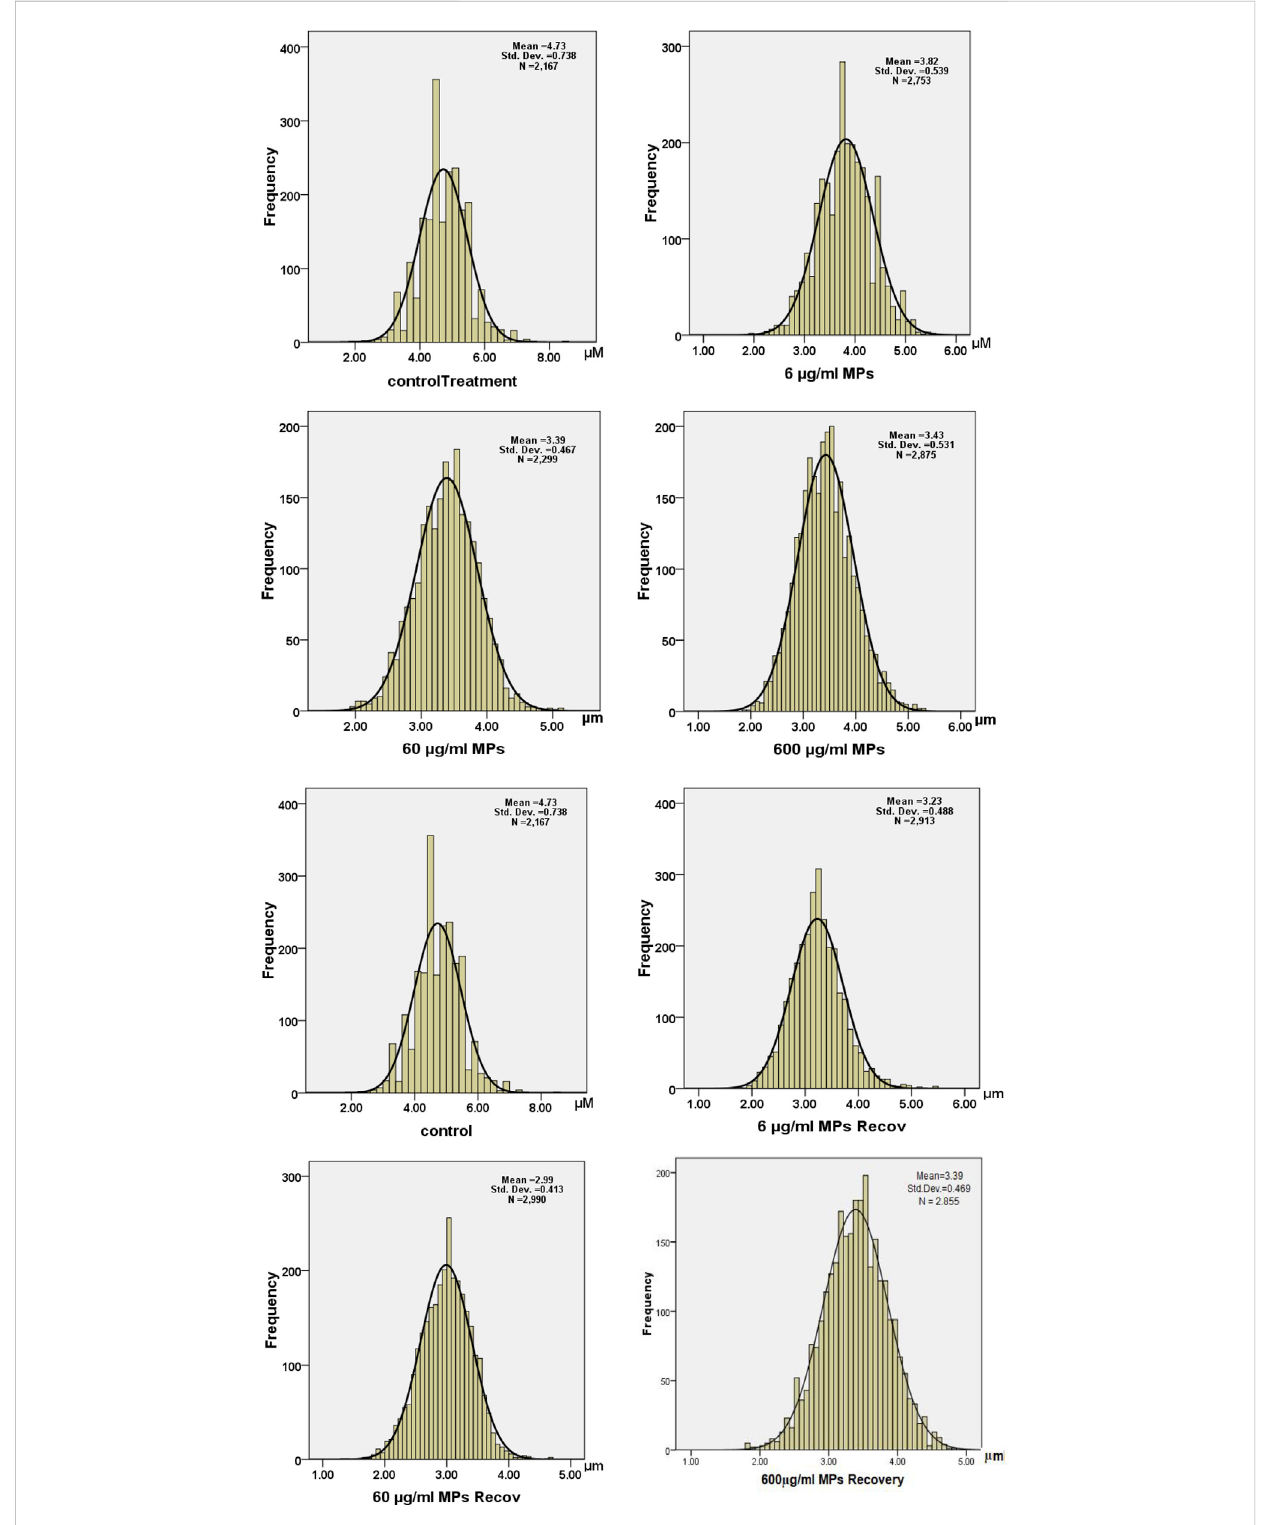
Histogram of diameters of erythrocytes in the exposure and recovery groups of the C57BL/6 murine